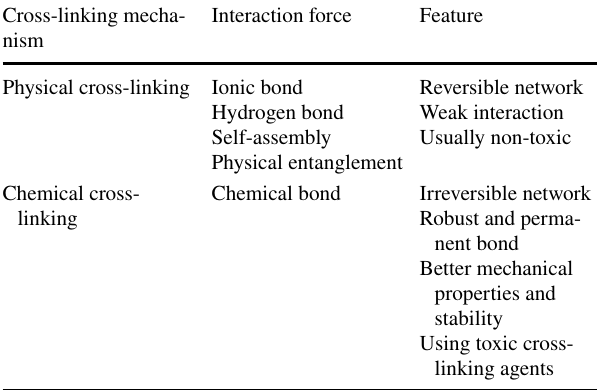
Table 1 Comparison of different synthesis mechanisms Cross-linking mecha-